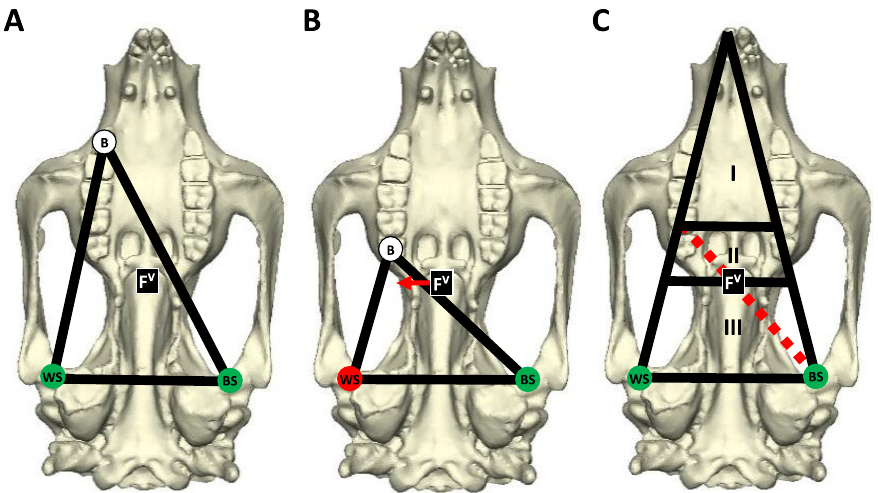
Fig 5. The constrained lever model of jaw biomechanics, as depicted on a koala cranium. (A) The triangle of support is formed from the biting tooth “B”, the working-side TMJ “WS”, and the balancing-side TMJ “BS”. The muscle resultant force vector “F V ” is centred during full recruitment of all adductor muscles. (B) The F V must be located within the triangle of support in order to maintain compressive forces at the working-side TMJ. Thus, biting at the posterior dentition can result in distractive forces at this joint unless the F V is shifted back within the triangle of support. This is achieved by reducing the balancing-side muscle forces applied. (C) The three regions of balance in the mammalian jaw: Region I extends from the bite point in line with the F V and balancing-side TMJ to all dentition anterior to this point; Region II exists between the posterior limit of Region I and the line of mediolateral F V intersection; Region III commences posterior to the mediolateral line of F V intersection and represents the edentulous portion of the cranium anterior to the TMJs.